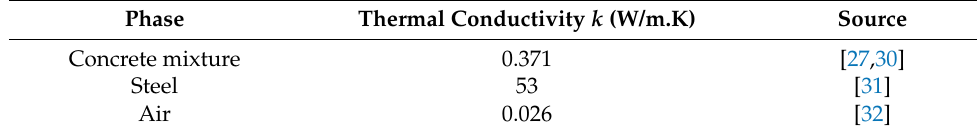
Table 1. Thermal conductivities of the materials considered in this